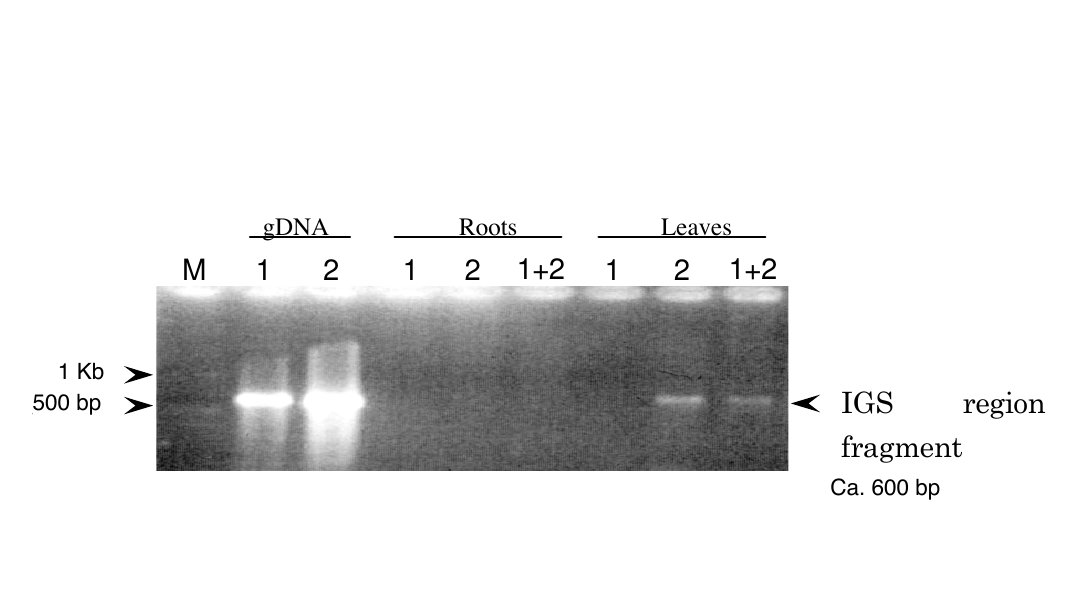
Fig. 3. PCR products with the IGS region primers using as template DNA extracted from the roots and leaves of tomato cv. Momotaro 16 days after inoculation. Lanes, M, 100-bp DNA marker; gDNA, fungal genomic DNA extracted from Fusarium oxysporum f. sp. lycopersici races 1, and race 2 was used as a template; roots, total DNA extracted from tomato cv. Momotaro roots inoculated singly with race 1, and with race 2, and jointly with races 1+2, was used as a template; leaves, total DNA extracted from tomato cv. Momotaro roots inoculated singly with race 1, and with race 2, and jointly with races 1+2, was used as a template.